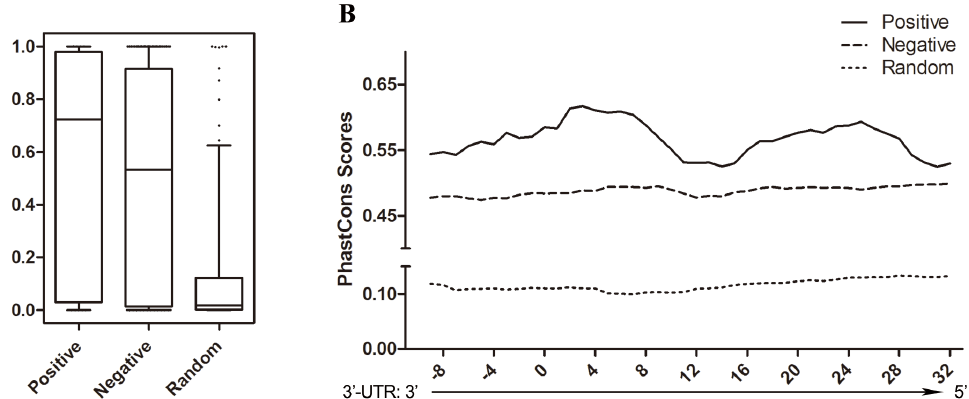
Figure 6. Conservation analysis of validated miRNA target sites. (A) The distribution of the average PhastCons score of predicted MREs in positive (n=101), negative (n=875) and random (n=203) groups. There were significant differences between positive and negative groups as well as between positive and random groups (Wilcoxon test, p , 0.05). (B) The PhastCons score of every nucleotide of MREs and boundary nucleotides in the three groups. The interactions with a SSMD value equal to or less than 2 3, which indicated the threshold of extremely strong inhibitive effects, were grouped to be positive. The nucleotides targeted by the miRNA seed region were designated as 2–8.